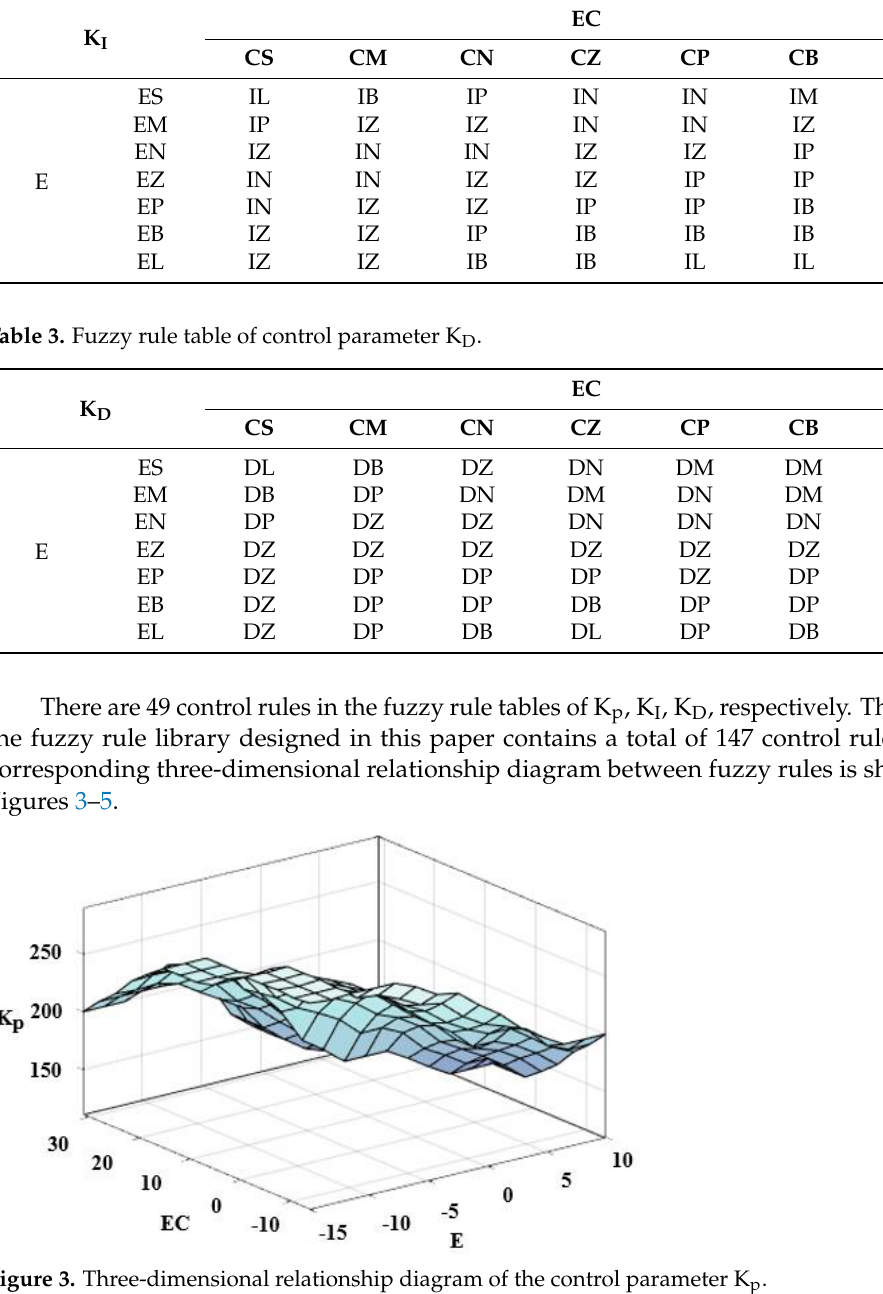
Figure 4. Three-dimensional relationship diagram of the control parameter K I . Figure 5. Three-dimensional relationship diagram of the control parameter K 𝐷 ⚫